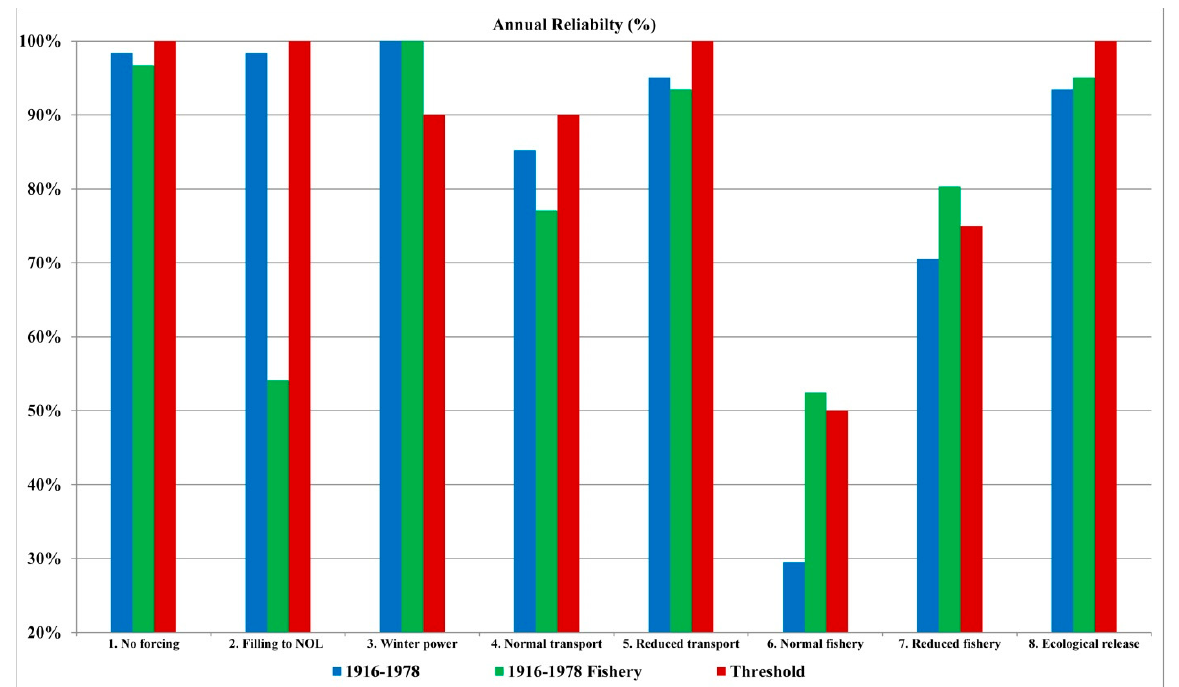
Figure 12. Reliability for water users’ requirements for the series 1916–1978 in comparison with the option in favor of fisheries and ecology.